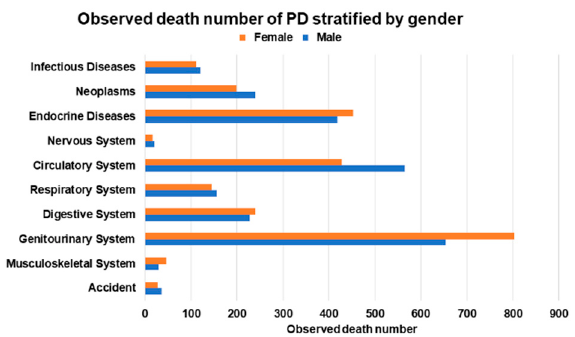
Figure 1. Observed death number of peritoneal dialysis (PD) stratified by gender.